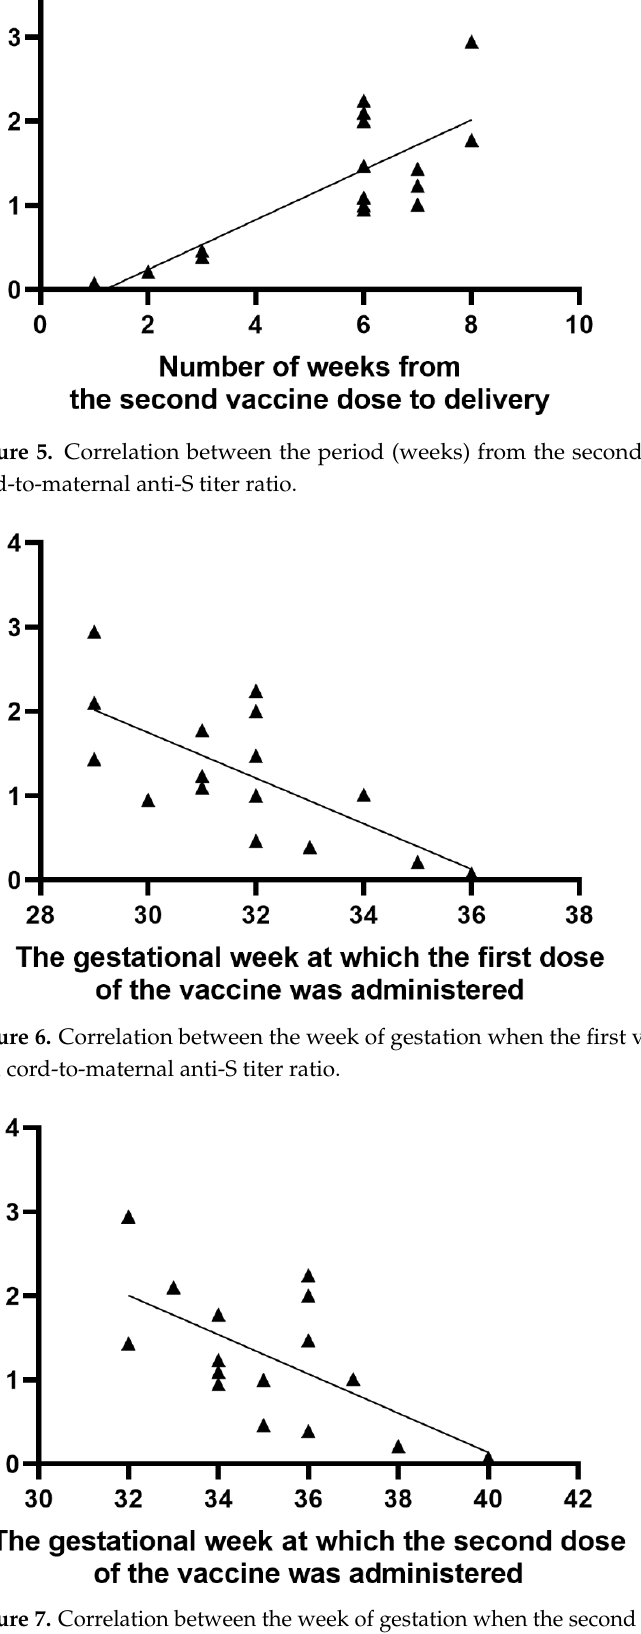
Figure 7. Correlation between the week of gestation when the second vaccine dose was administered and cord-to-maternal anti-S titer ratio. No significant variations were reported in anti-S antibody titers based on maternal age, body mass index (BMI), or the interval between vaccine doses.